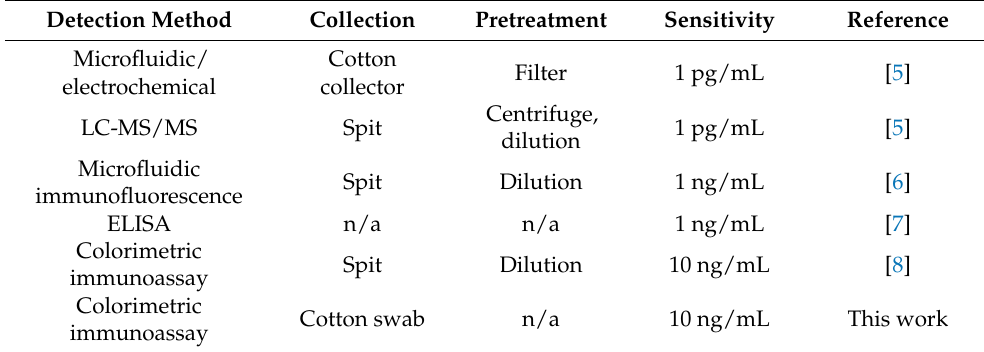
Table 1. Traditional methods for the determination of salivary cotinine.